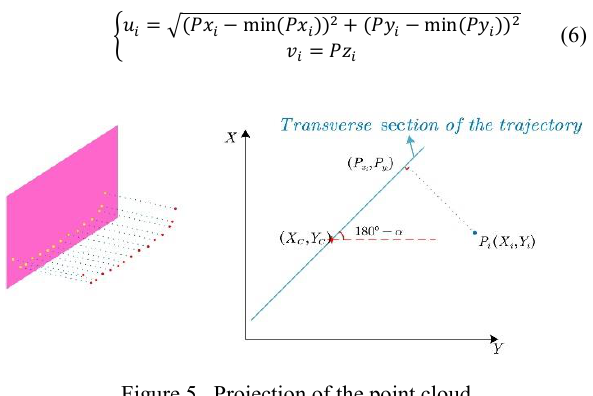
Figure 5. Projection of the point cloud